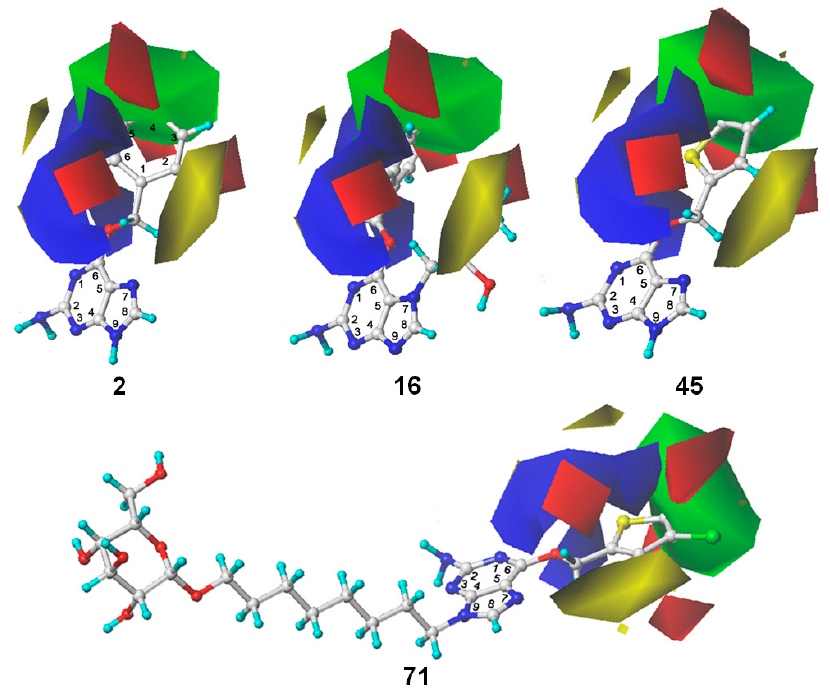
Figure 3. The CoMFA STDEV*COEFF contour maps for compounds 2 , 16 , 45 and 71 . The green and yellow region represent the sterically favorable and unfavorable properties, respectively. The blue and red region represent the electropositive and electronegative favorable properties, respectively.